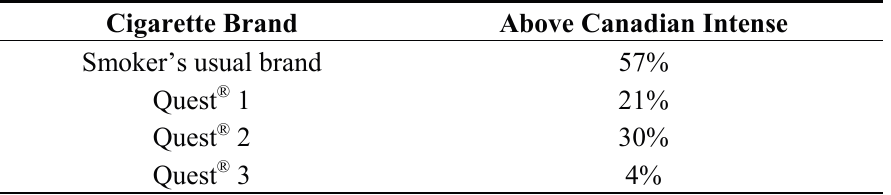
Table 5. Percentage of subjects’ spent filter butts that exhibited a higher yield of BaP than the butts from machine-smoked ones with the Canadian intense